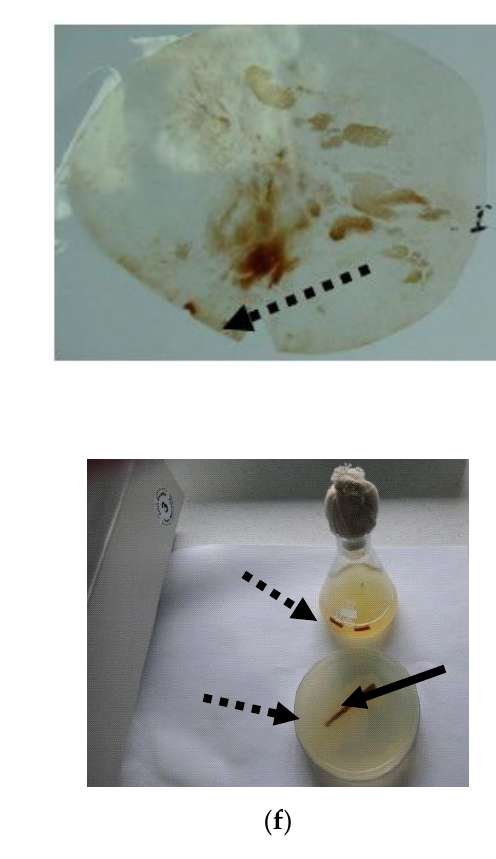
Figure 2. Testing the viability of Bacillus spores in various mixtures, ( a – b ) atomized preparate; ( c – d ) composite pieces. ( a ) Atomized bacterial—dextrin mixtures; ( b ) Solid and liquid cultures on LB medium inoculated with atomized preparate; ( c ) Microscopically observations of viable spores from atomized bacterial—dextrin mixtures; ( d ) Bacillus amyloliquefaciens 1014 spores embedded in polypropylene. (dotted arrow—polypropylene piece sampling); ( e ) Cultivation on solid LB medium (white square and dotted arrow—polypropylene sample from Figure 2d placed on nutrient medium; black arrow— bacterial growth from viable spores); ( f ) Cultivation on solid and liquid LB medium (dotted arrow—polypropylene sample placed on/in nutrient medium; black arrow—bacterial growth from viable spores).